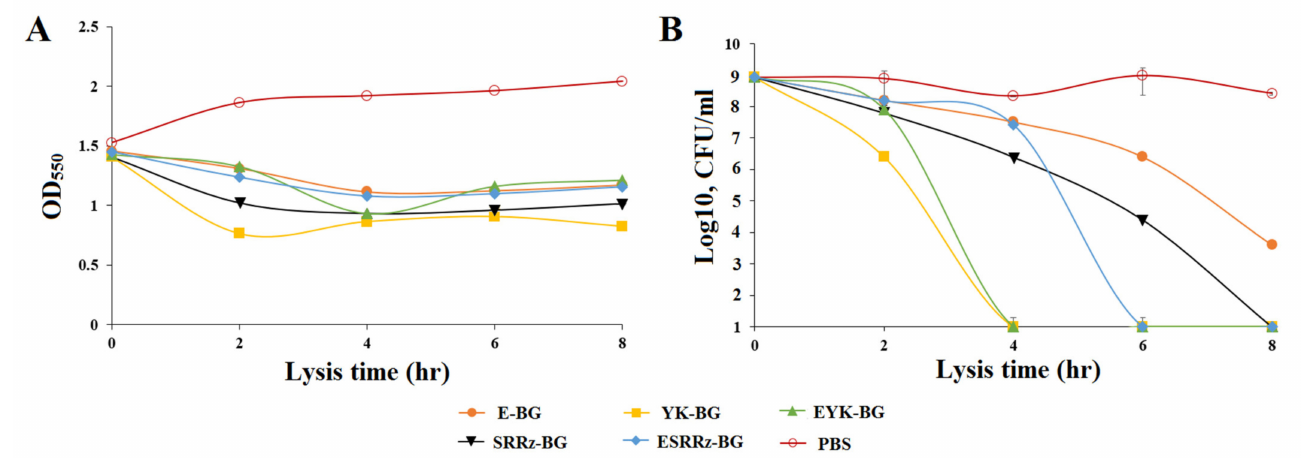
Figure 2. The lysis kinetics of Y. pestis KM260(12) ∆ lpxM harboring different lysis plasmids. Lysis was monitored by the measurement of the OD 600 ( A ) and the determination of the number of CFU ( B ). Y. pestis BGs grown to exponential phase were inactivated by induction of the lysis genes. The CFU counts were transformed to log base 10 values. The data are presented as the mean ± s.d. of three